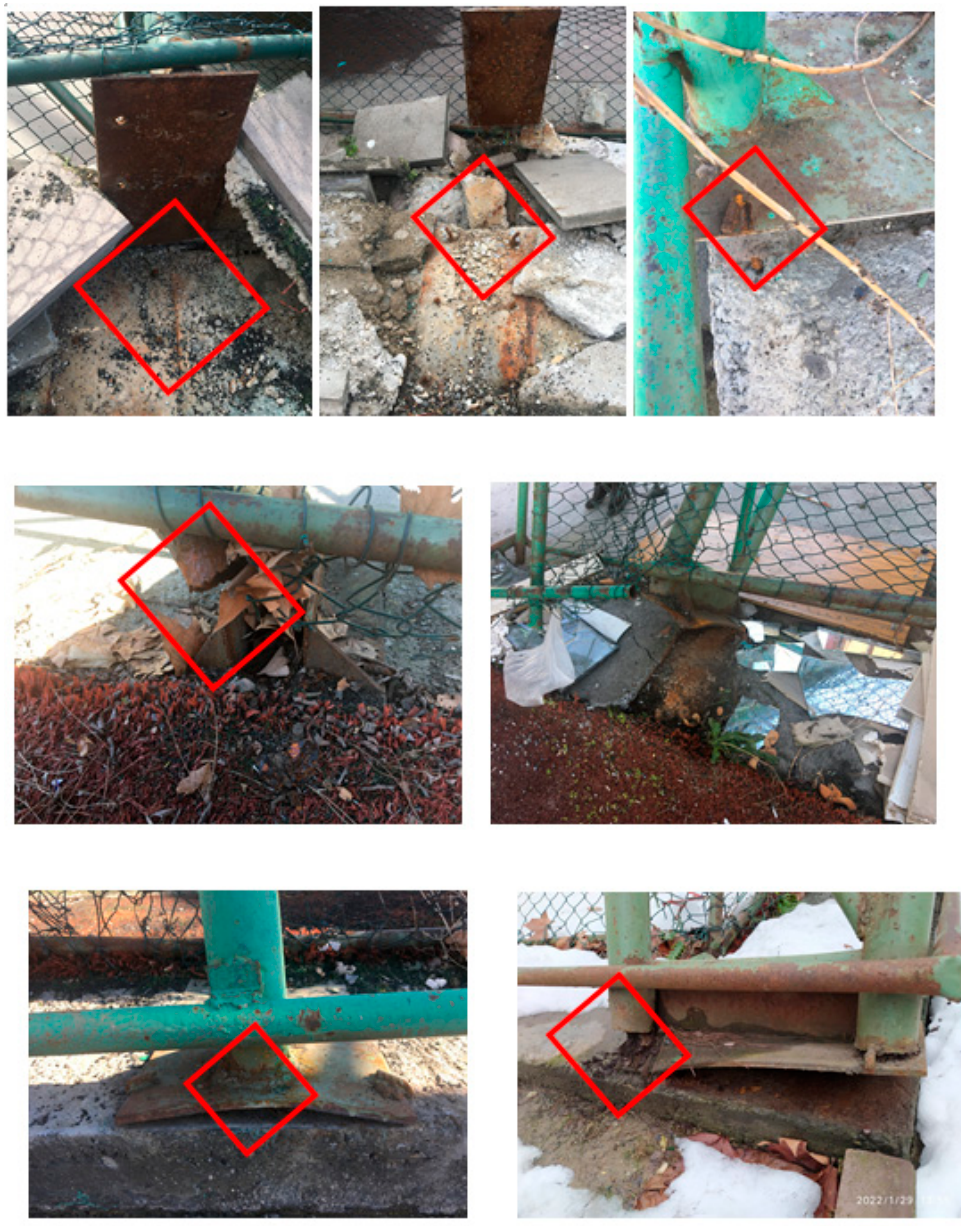
Figure 7. Failure of the column support plates.